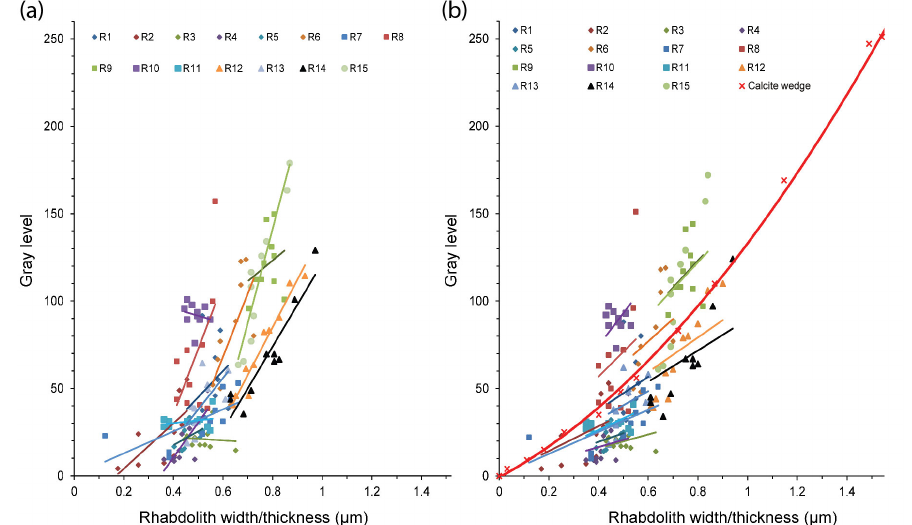
Figure 5. Relationship between grayscale and thickness for 15 individual Rhabdosphaera clavigera rods (R1 to R15), and thickness for the calcite wedge (red line) measured under identical light conditions. The rhabdolith thickness is assumed to the diameter of the rod at the point of grayscale measurement. (a) Natural trend of different rhabdoliths. (b) Rhabdoliths forced to pass for the coordinate origin (requirement for the calibration software). The calibration values for sigmoidal calibration range from a minimum of 0.0024 to a maximum of 0.0113, with a mean of 0.0059 and standard deviation of 0.0024. The calibration values for linear calibration range from 0.054 to 0.0252, with a mean of 0.0131 and standard deviation of